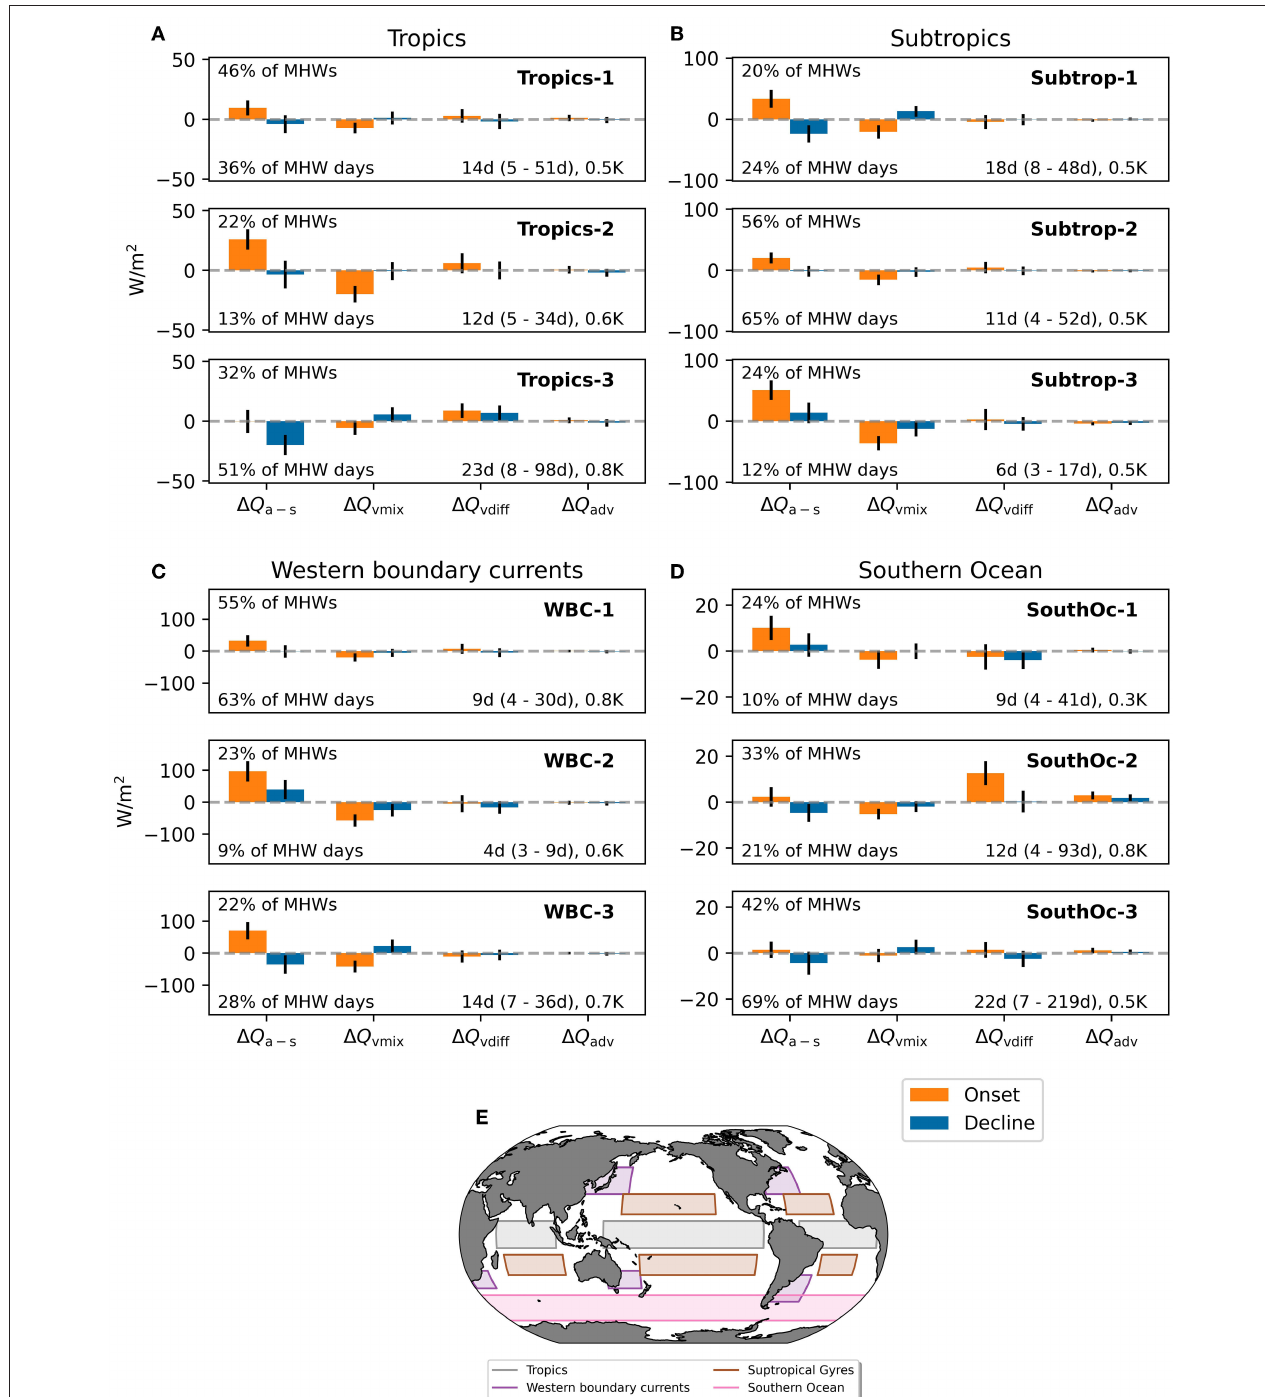
FIGURE 8 | (A–D) Marine heatwave types identified by K-Means clustering in four selected regions. Error bars show the standard deviation of each driver’s anomaly among marine heatwaves of each type. The median duration (in days), median maximal magnitude (in Kelvin) and the percentage of marine heatwaves and marine heatwave days occupied by marine heatwaves of each type are also given. Note the different y -axis scales used for different regions. The bottom panel (E) shows the definition of the regions. The definitions of the western boundary current regions are as in Hayashida et al. (2020), Figures 5, 6 therein.